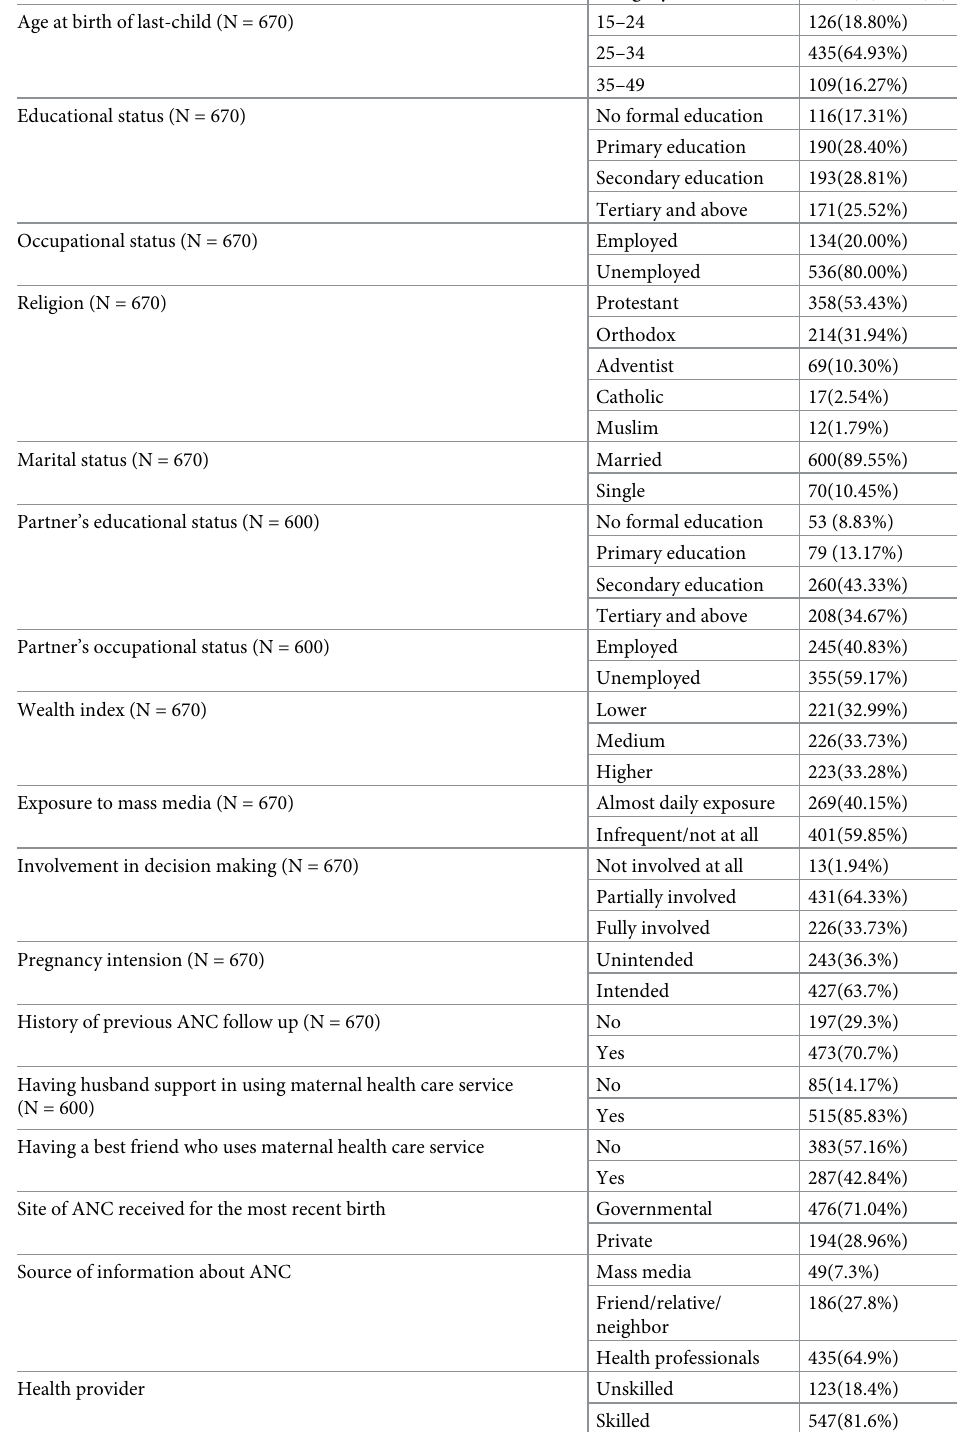
Table 2. Socio-economic and reproductive characteristics of women in Southern Ethiopia,